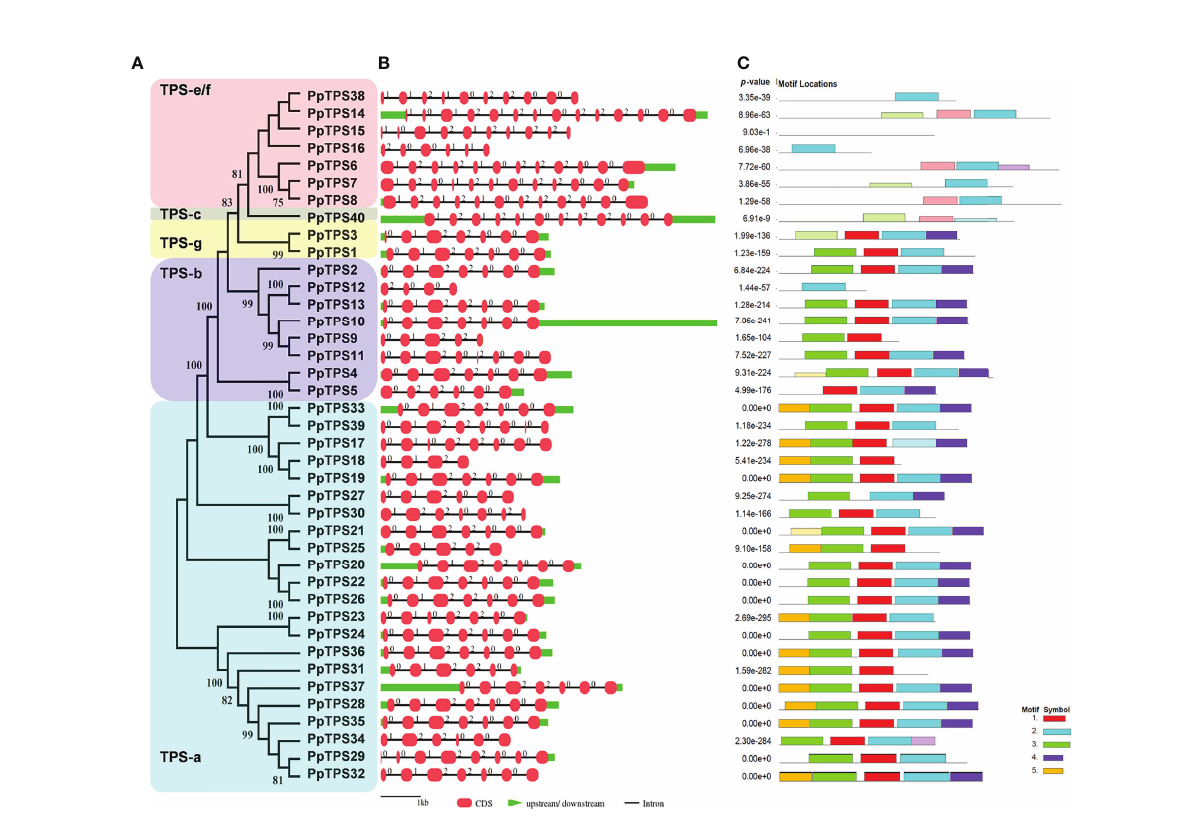
FIGURE 2 Structural analysis of PpTPS genes. (A) A phylogenetic tree of forty full-length PpTPS proteins. (B) A schematic graph shows the exon-intron organizations of PpTPS genes. (C) The organization of fi ve protein motifs in PpTPSs predicted by MEME online tools. The detailed sequences of protein domains in PpTPSs were presented in Supplementary Figure